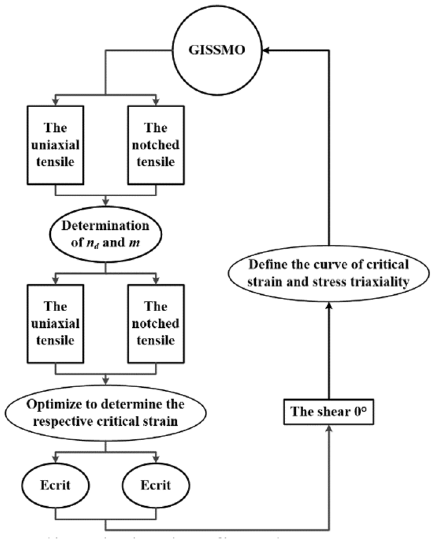
Figure 6 Overall optimization flowchart